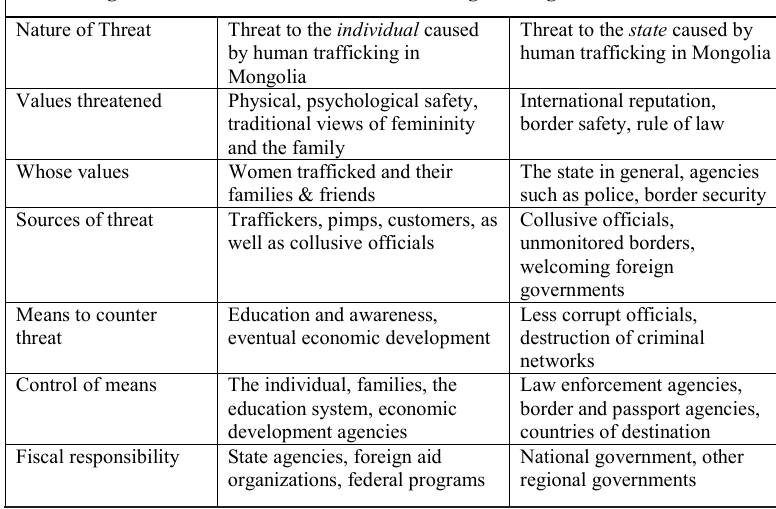
Fig. 1- Six Dimensions of Human Trafficking in Mongolia